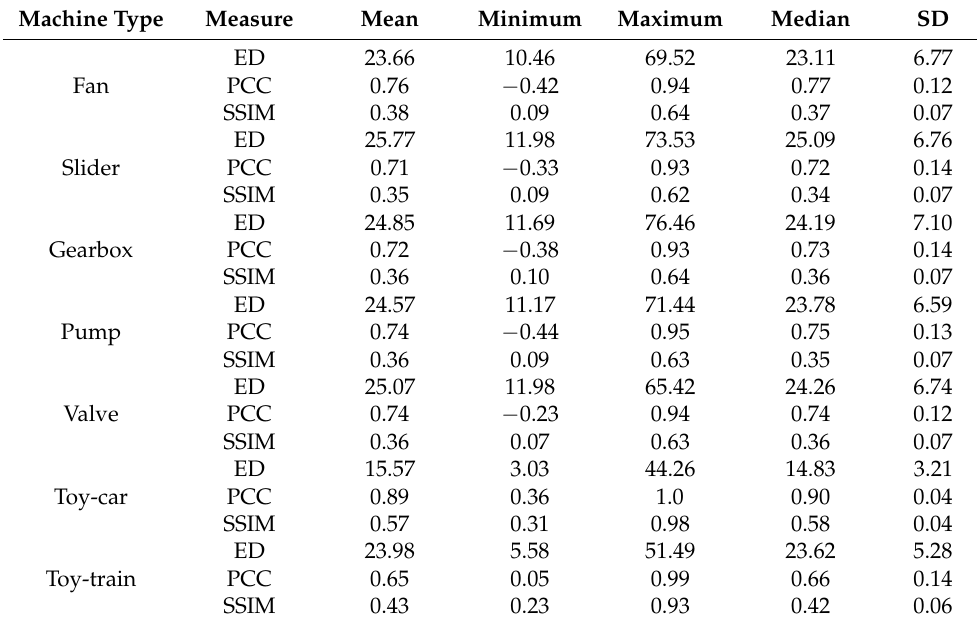
Table 1. Statistical quantities of intraclass similarity measures (ED, PCC, and SSIM) obtained using the full